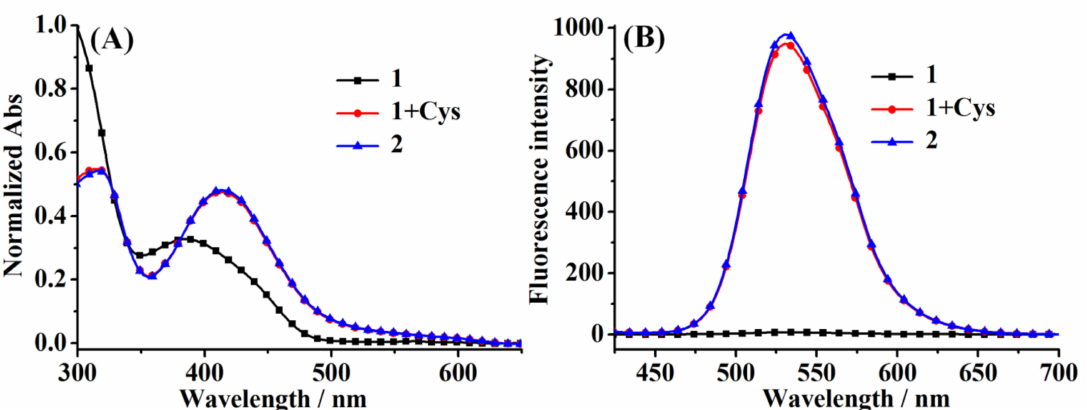
Figure 1. Normalized absorption ( A ) and fluorescence emission spectra ( B ) of probe 1 (5 µ M), probe 1 (5 µ M) with Cys (100 µ M) with 15 min of reaction time, and compound 2 (5 µ M) in the solution containing PBS buffer (pH = 7.4, 50.0 mM) and 20% of DMSO ( λ exc = 413